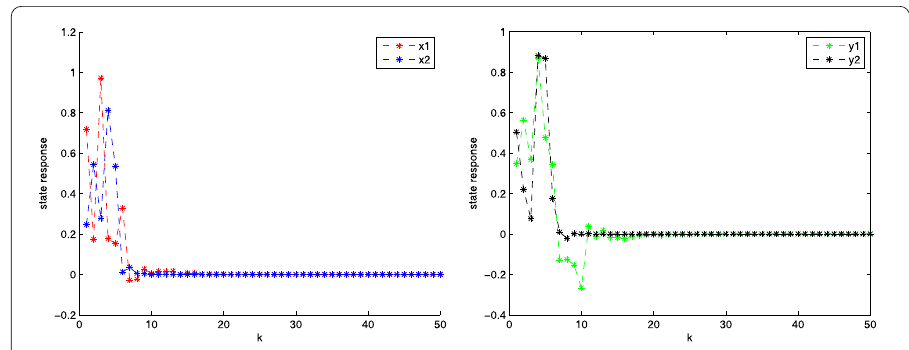
Figure 1 The state response x ( k ), y ( k ) of (1)-(4) with leakage delay.